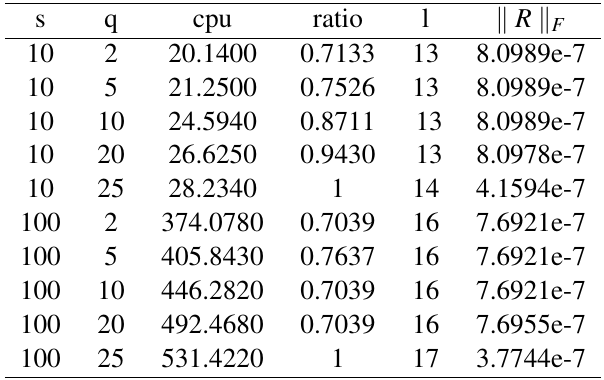
Table 1 The Global GMERRSL (25) and the Incomplete Global GMERRSL (25) (s = 10 and s =